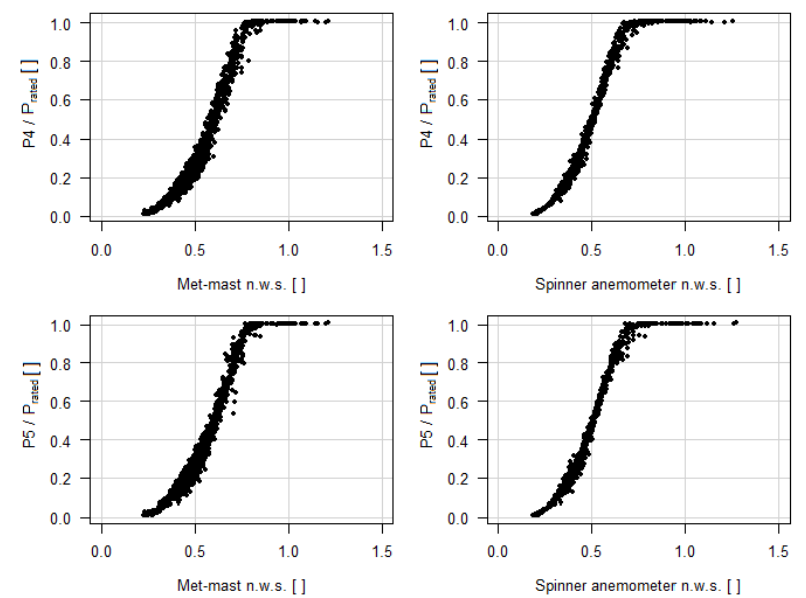
Figure 5. Scatter plot of 10min averages of power as a function of spinner anemometer normalized wind speed (n.w.s.) and met-mast normalized wind speed measurements, for wind turbines 4 and 5, before application of the NTF and before air density correction. Met-mast measurements to the left, and spinner anemometer measurements to the right. Turbine 4 measurements upper and turbine 5 measurements lower. Data refer to the same measurement period. P4 is the power output of wind turbine 4, and P5 is the power output of wind turbine 5.